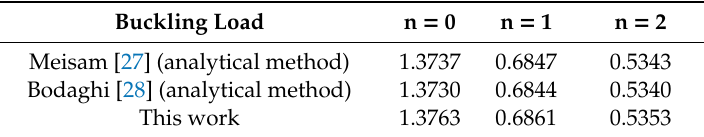
Table 1. Comparison of the critical buckling load (MN / m) for a simply supported FGM plate ( a = b = 1 m, h = a / 100).